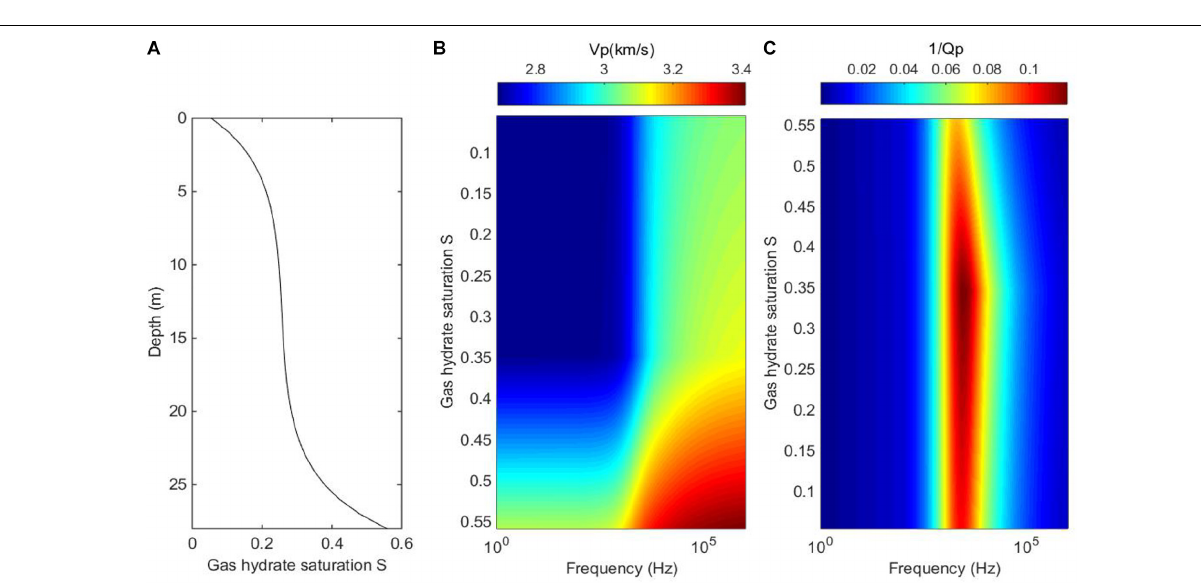
FIGURE 12 | (A) The model of heterogeneous hydrate saturation varying with depth; (B) the P-wave velocity Vp dispersion; and (C) corresponding P-wave attenuation factor 1/Qp.